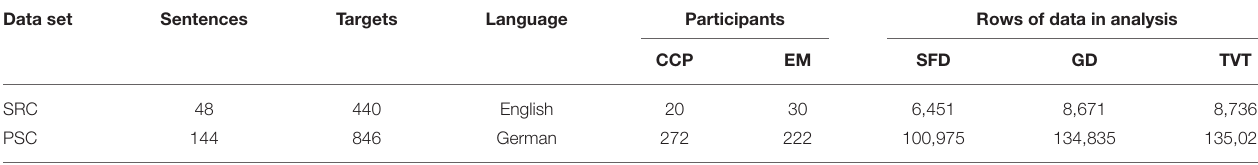
TABLE 1 | Overview about cloze completion and eye movement (EM) data used for the present study.